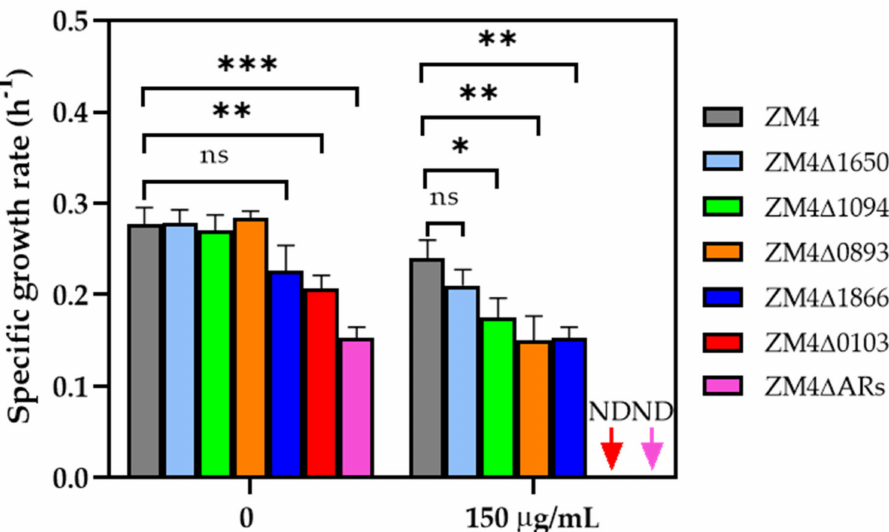
Figure 2. The specific growth rate of ampicillin − resistant (AR) gene knockout strains cultured under 0 and 150 µ g/mL of ampicillin. Three replicates were performed for the experiment. When the mutant could not grow under the condition, the sample is marked “ND” (not detected). * represents a significant difference with p − value < 0.05. ** represents a significant difference with p − value < 0.01. *** represents a significant difference with p − value < 0.001. ns represents no significant